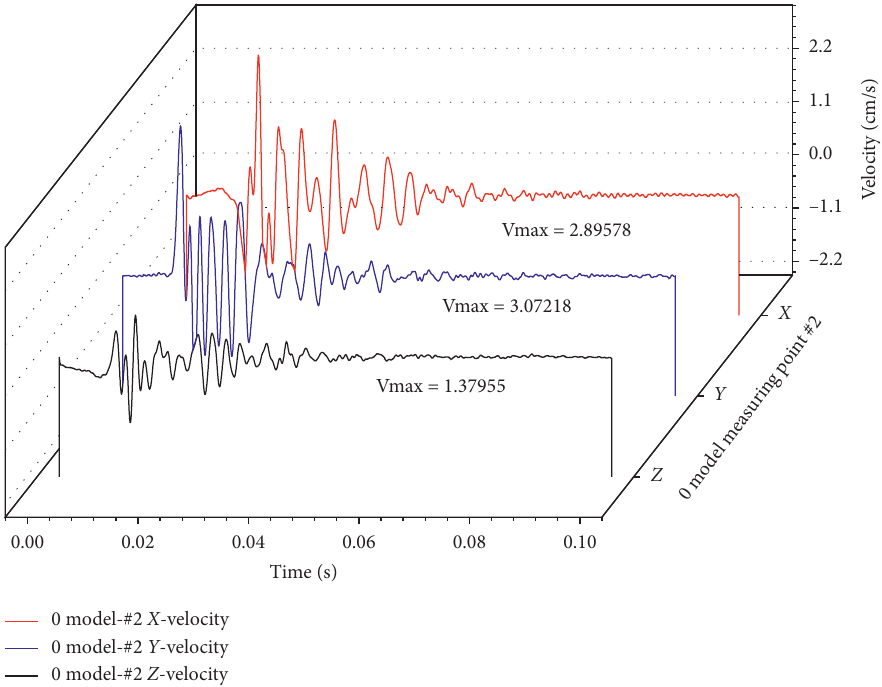
Figure 7: Vibration time history curves of the No. 0 model and #2 measuring point.